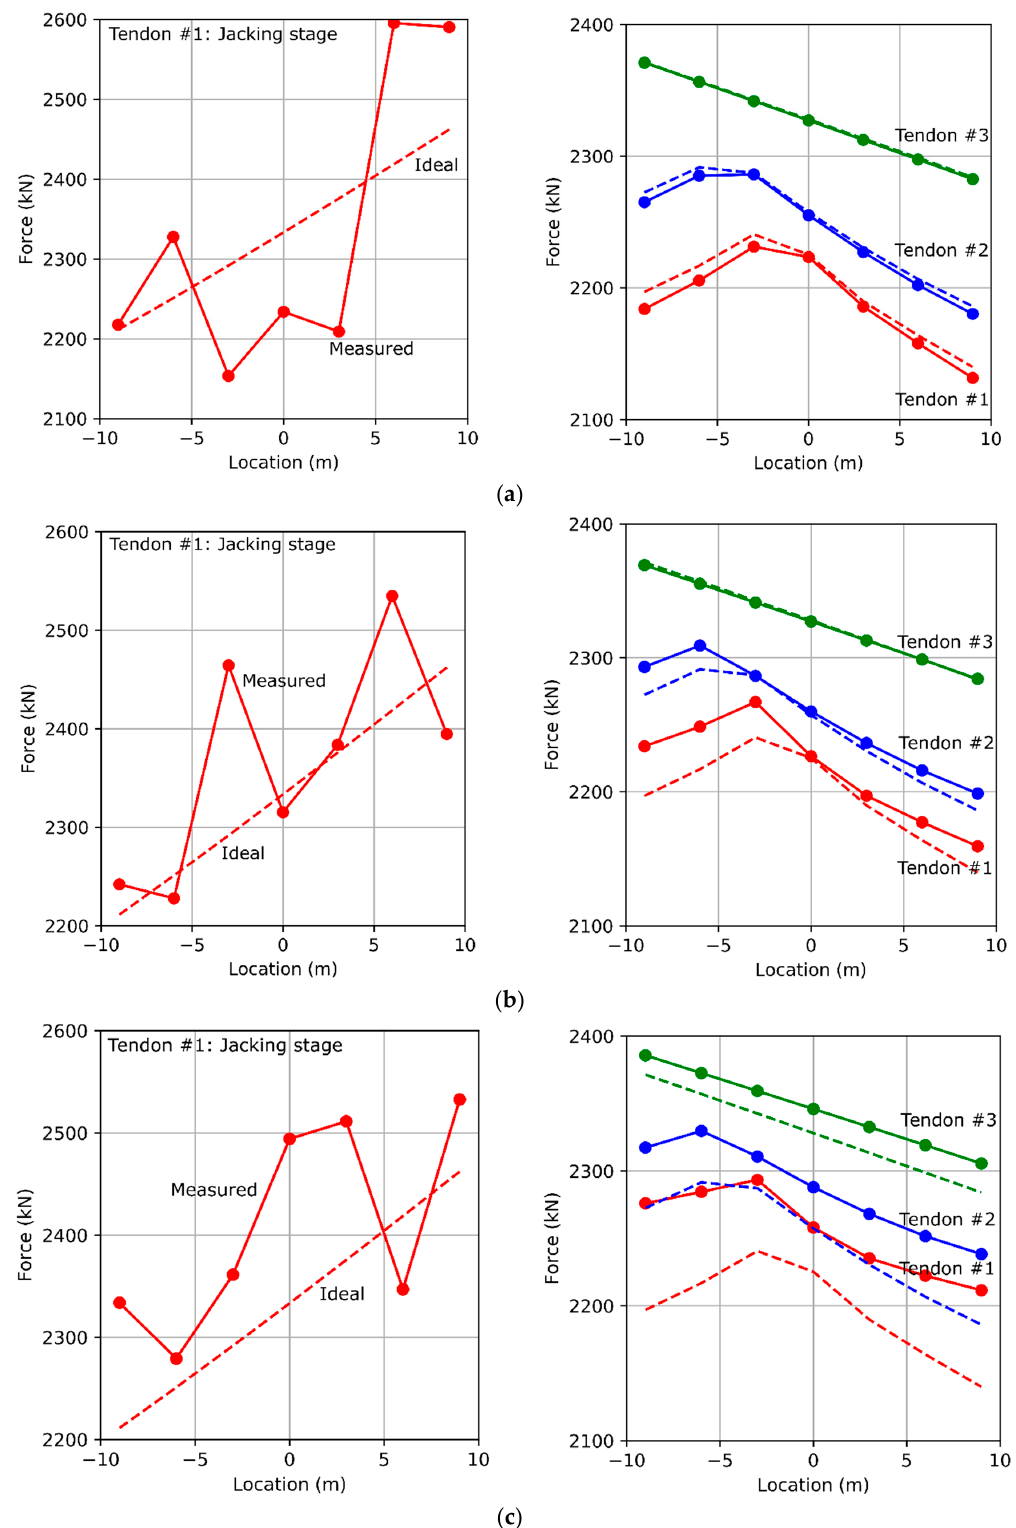
Figure 6. Comparison of prestress force distribution in cases where the strain measured by the smart strand shows definite fluctuation: ( a ) Variation #1: the smallest error; ( b ) Variation #7: the median error; ( c ) Variation #10: the largest error.